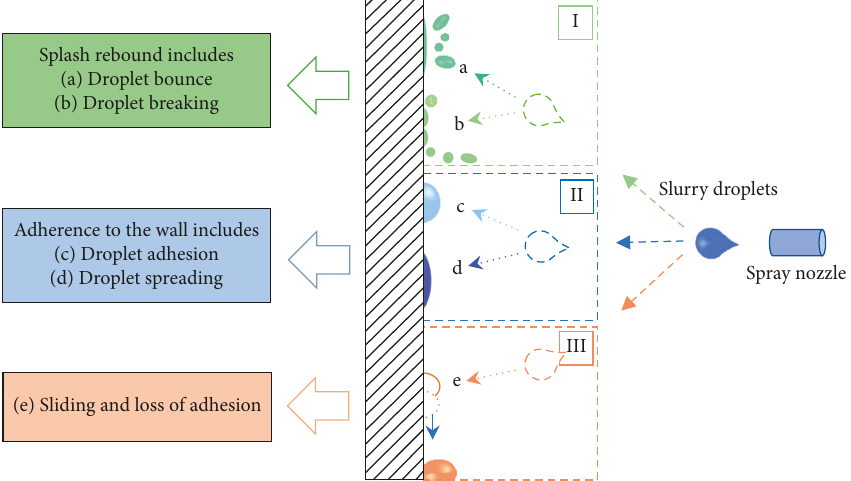
Figure 2: Classification of slurry droplet impacts on a wall: (I) splash rebound, (II) adhesion to the wall, and (III) sliding and loss of